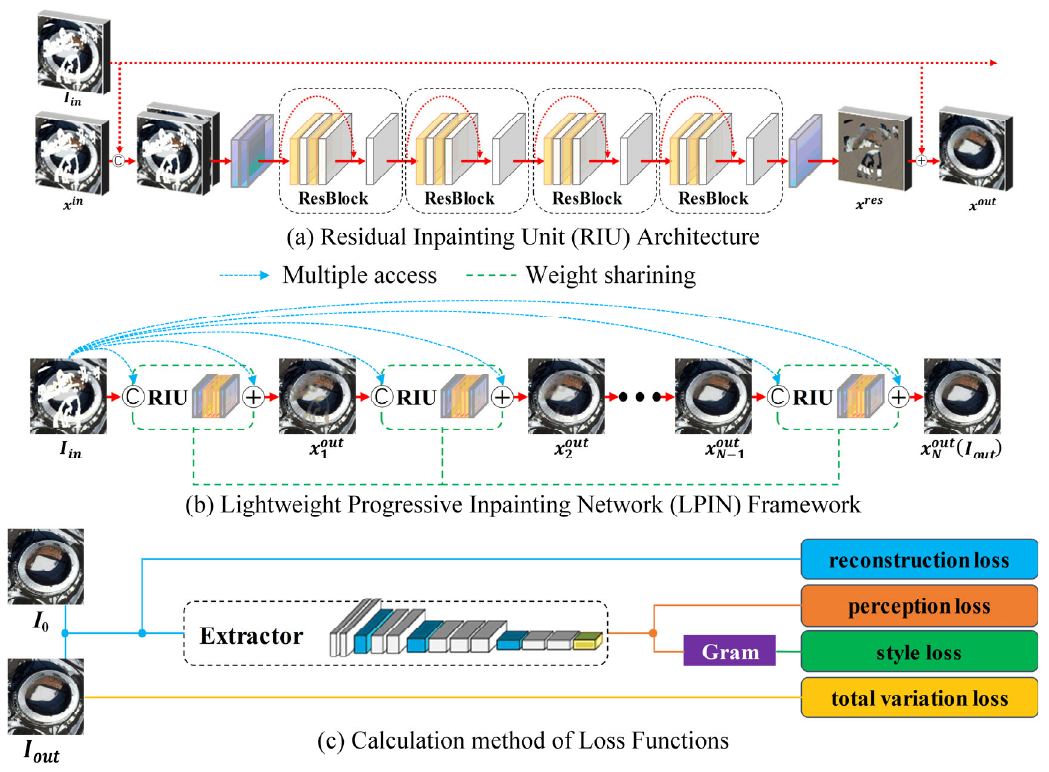
Figure 3. Overall inpainting architecture of proposed approach. ( a ) is the basic residual inpainting unit (RIU) combined of four residual blocks and can generate a preliminary result. ( b ) is the frame ‐ work of our LPIN consisted with several RIUs. ( c ) is the calculating process of the loss functions. 𝐼 (cid:2868) is the real image without defects, 𝐼 (cid:3036)(cid:3041) is the corresponding image with defects, 𝑥 (cid:3036)(cid:3041) is the input of RIU, 𝑥 (cid:3045)(cid:3032)(cid:3046) is a residual output, 𝑥 (cid:3036)(cid:3042)(cid:3048)(cid:3047) is the output of the i ‐ th RIU and 𝑥 (cid:3015)(cid:3042)(cid:3048)(cid:3047) is the output of the last RIU, i.e., the final inpainting result 𝐼 (cid:3042)(cid:3048)(cid:3047)